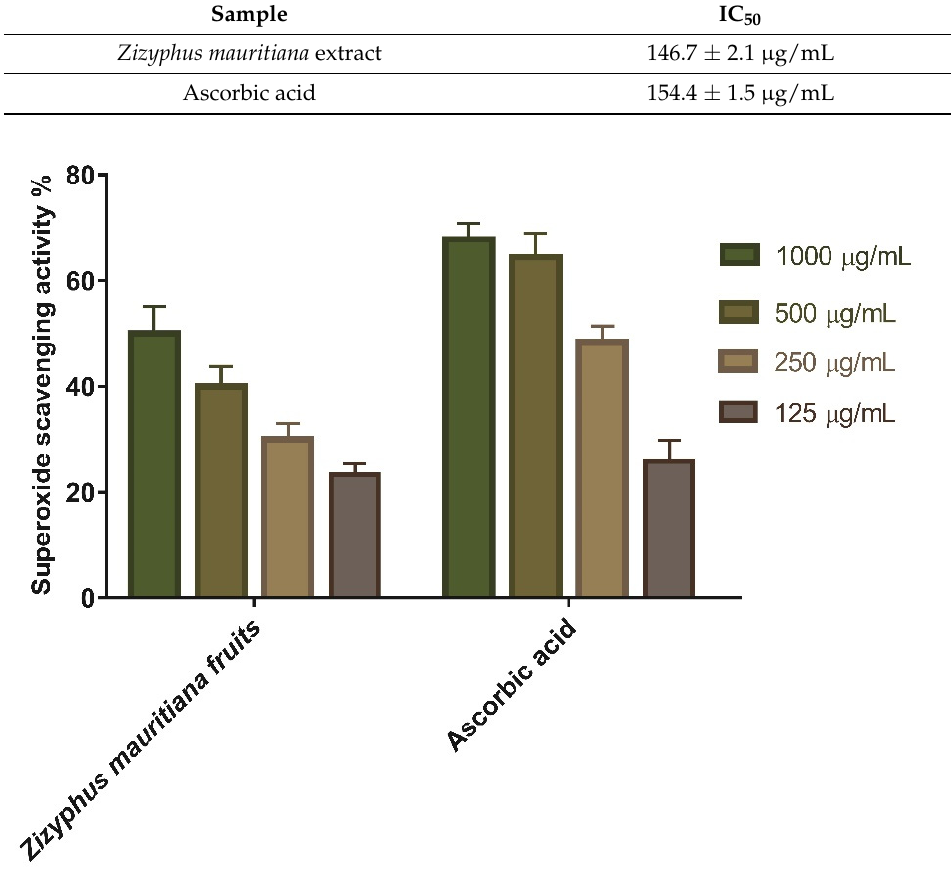
Figure 2. Superoxide radical scavenging activity of Z. mauritiana fruit extract at different concentration (1000, 500, 250, and 125 µ g/mL). Bars represent mean ± SD (standard deviation). The significant difference between test groups analyzed by a Two-way ANOVA test after normalization of variables by the Shapiro Wilk test.